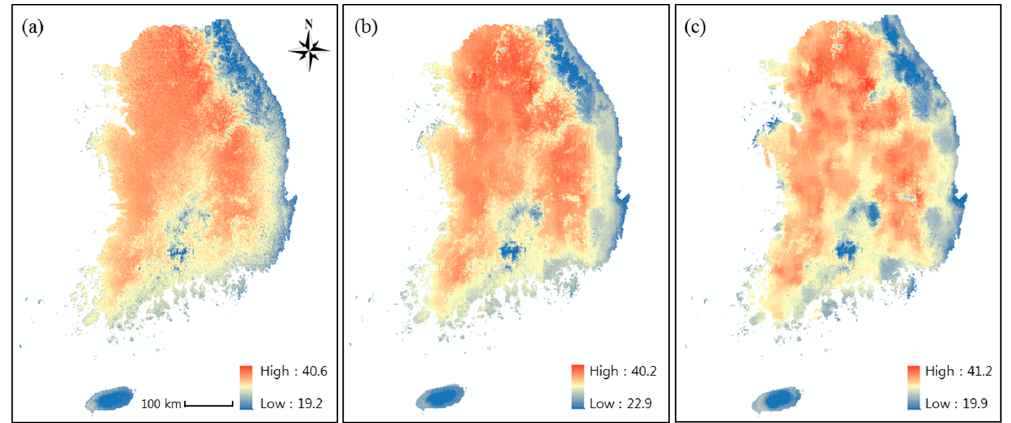
Figure 4. Daily maximum temperature on 1 August 2018, downscaled to a 1 km resolution: ( a ) SVM; ( b ) RF; and ( c ) GPRM. Units in the legend are degrees Celsius.